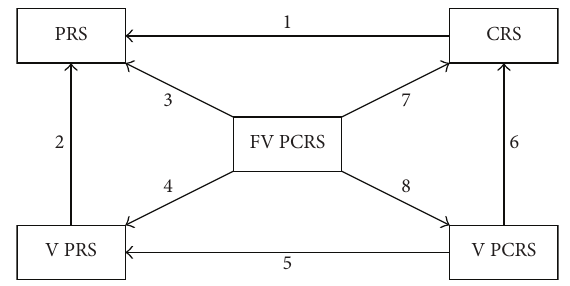
Figure 1: Relationships among five types of rough